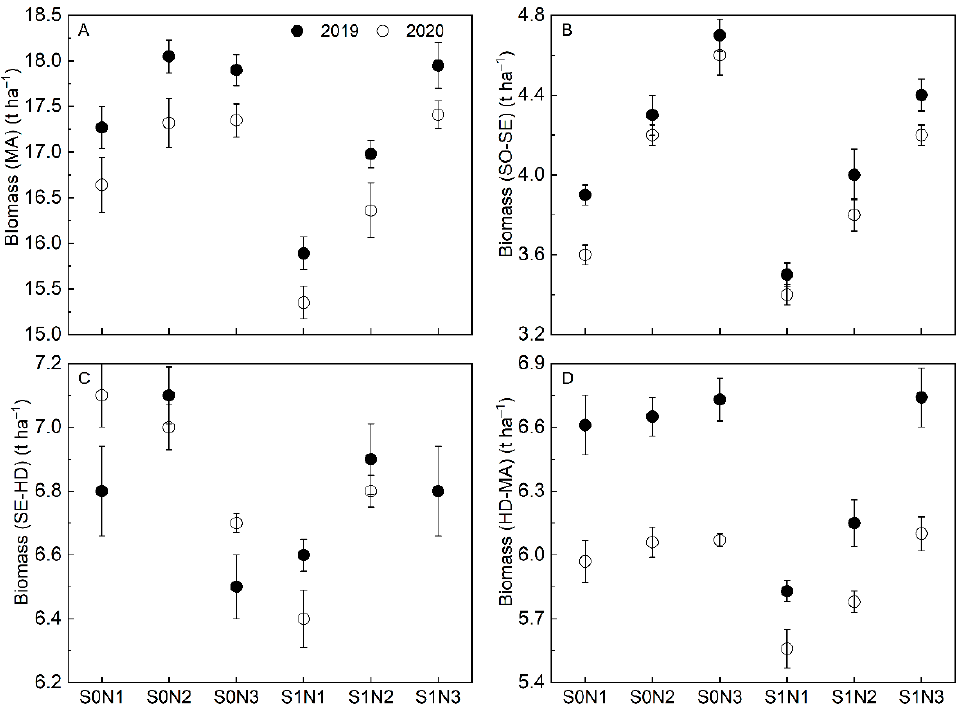
Figure 4. Biomass accumulation at MA ( A ); SO-SE ( B ); SE-HD ( C ); and HD-MA ( D ) for all treatment combinations in 2019 and 2020. SO: sowing stage; SE: stem elongation stage; HD: heading stage; MA: maturity stage. S0 and S1 represent treatment without wheat straw returning and treatment with wheat straw returning, respectively. N1, N2, and N3 represent early N management of 65 kg N ha − 1 , 95 kg N ha − 1 , and 125 kg N ha − 1 , respectively. The information of these treatments was shown in Table 1. Error bars show standard error of replicates ( n = 3).